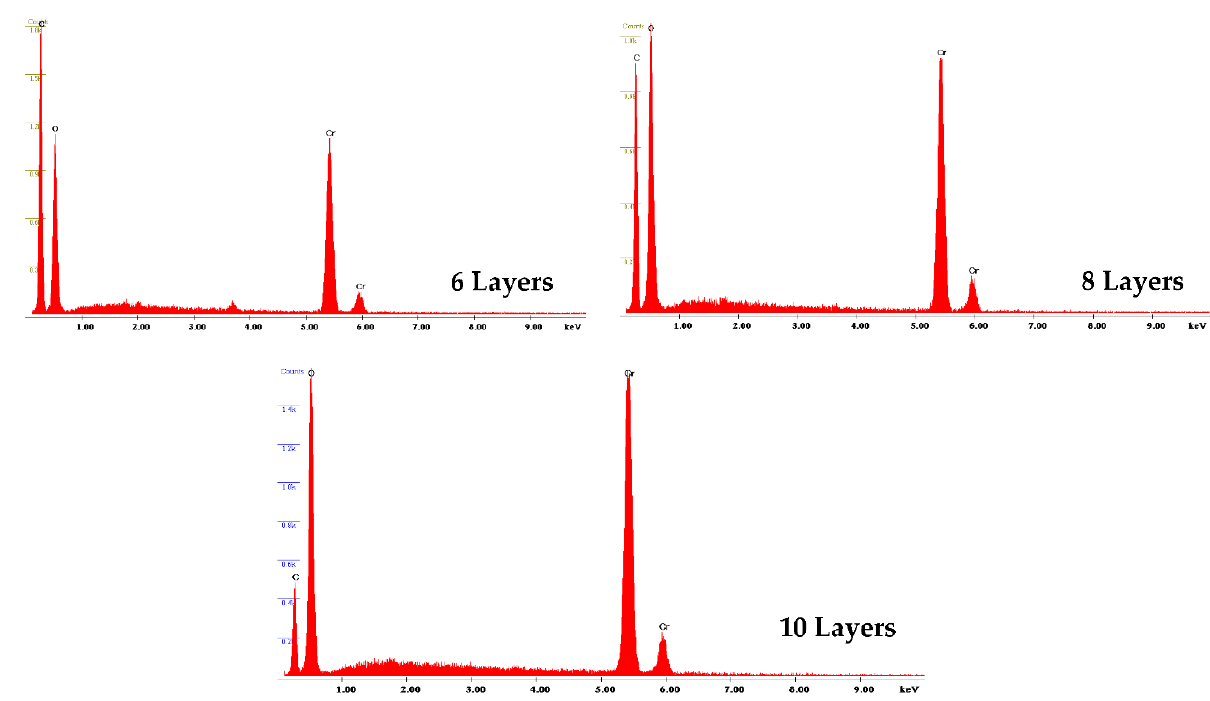
Figure 3. Spectrum obtained by scanning electron microscopy (SEM) energy dispersive spectroscopy (EDS) for samples of the films under study (6 layers, 8 layers, and 10 layers).